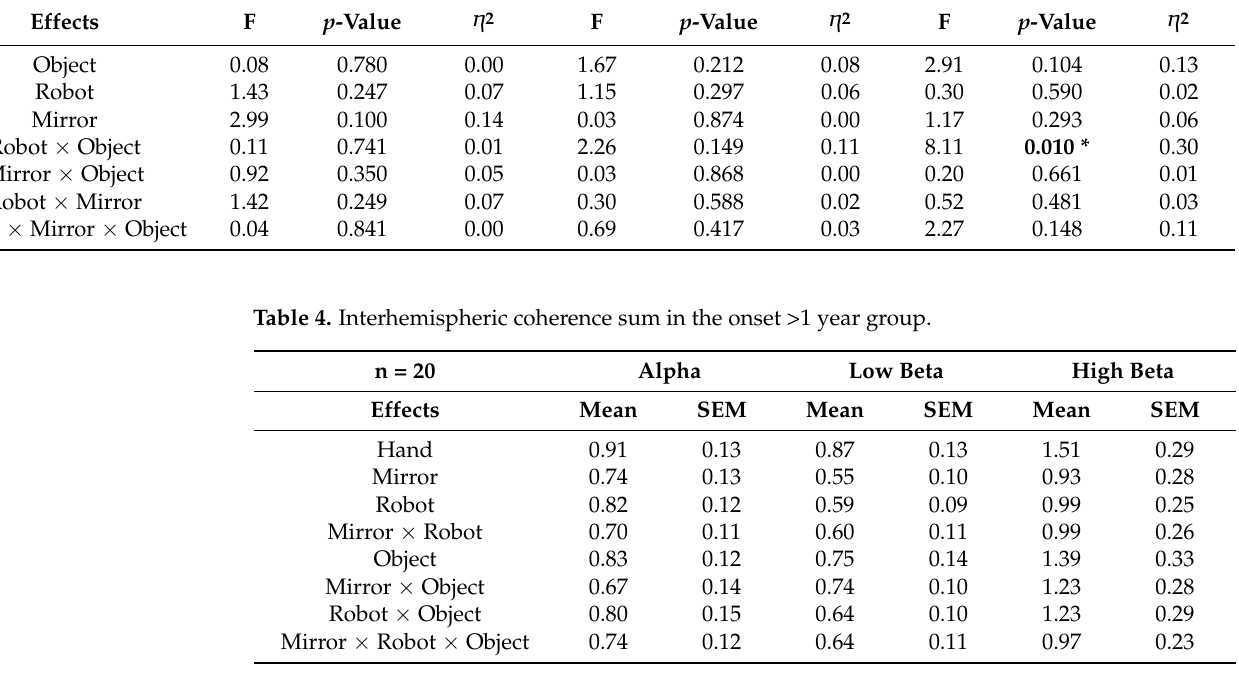
Table 5. Main effect analysis in the onset >1 year group. * p < 0.05.